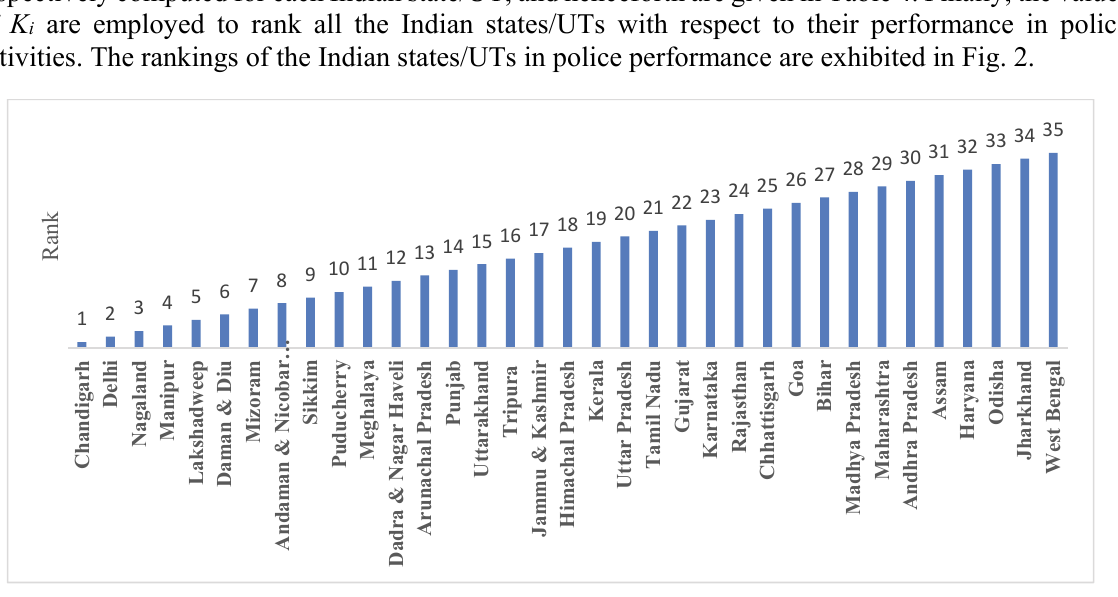
Fig. 2 Rankings of Indian states/UTs with respect to police